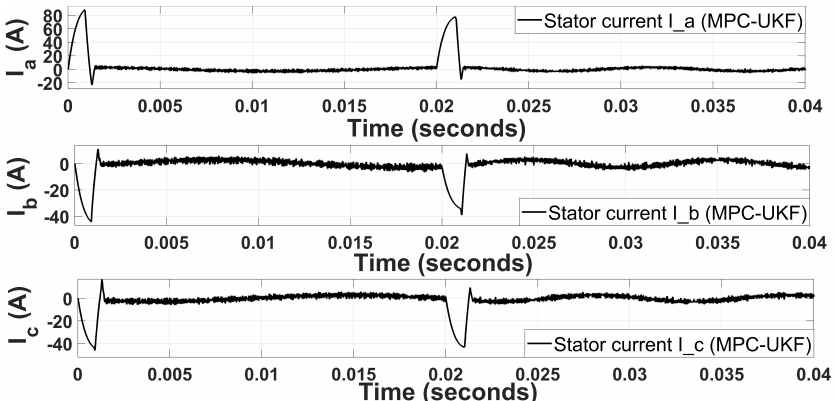
Figure 4. Three-phase stator currents for MPC-UKF.